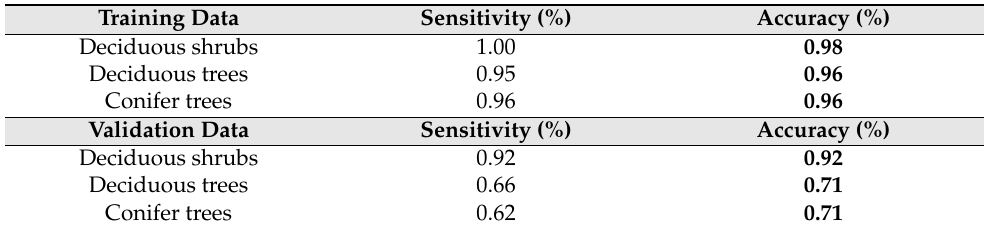
Table 3. Model performance for the study area. Sensitivity is the percentage of time each observed category was correctly predicted, while accuracy takes into consideration how well each category was predicted and how often it was miscategorised.